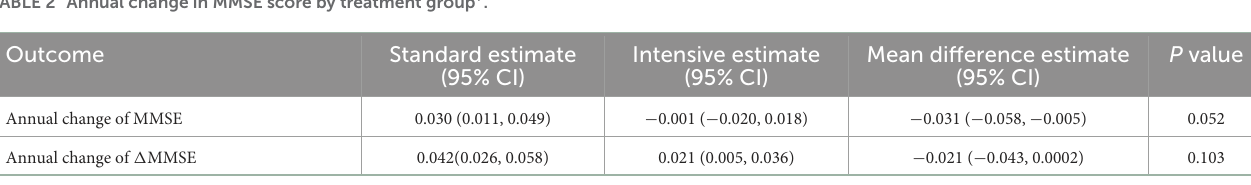
TABLE 2 Annual change in MMSE score by treatment group ∗ .